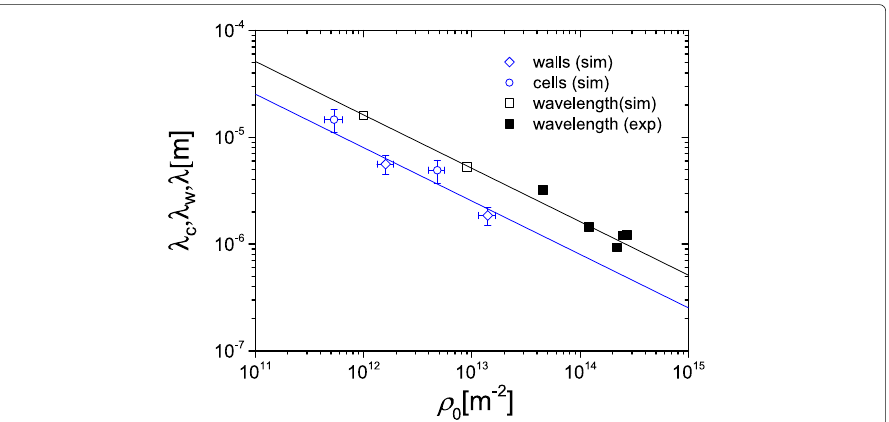
Fig. 8 Length scales vs dislocation densities in simulated cell structures; open circles: cell interiors, open diamonds: cell walls, the error bars indicate the standard deviation of data obtained from 10 interiors/walls determined from intercept method as explained in text; open squares: overall pattern wavelength vs average dislocation density; full squares: experimental pattern wavelength vs average dislocation density data (Oudriss and Feaugas